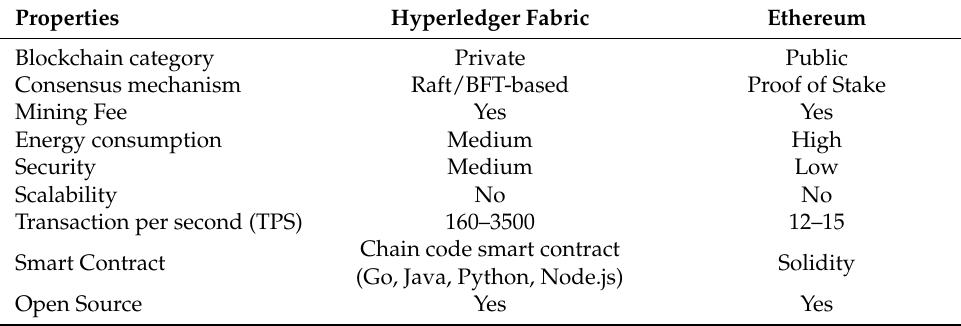
Table 10. Comparison of consensus mechanisms for smart contracts.